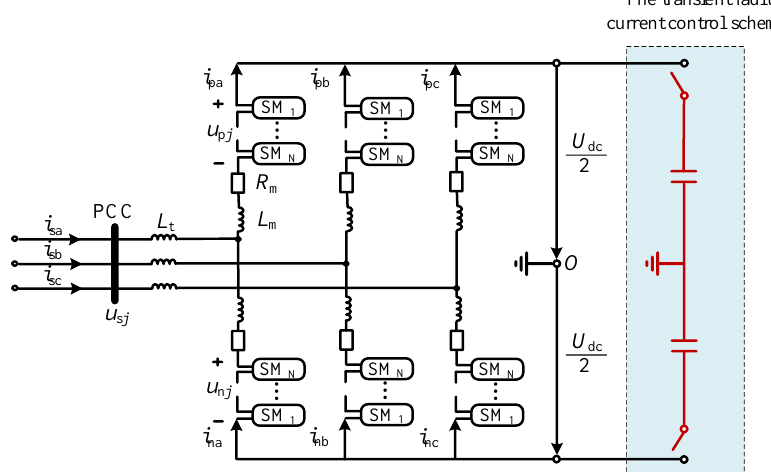
Figure 9. The transient fault current control scheme.